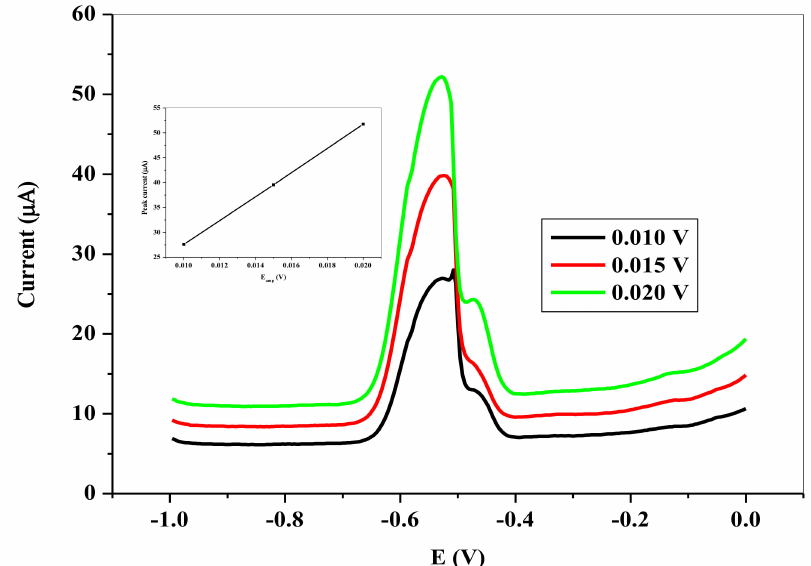
Figure 14. SWVs showing influence of pulse amplitude on the stripping peak current of 6.0 × 10 − 5 M Pb 2+ in 0.1 M HCl electrolyte on SPCE/OPE/BIONPs/PANI, 1200 mV deposition potential, 180 s deposition time, (Potential vs.